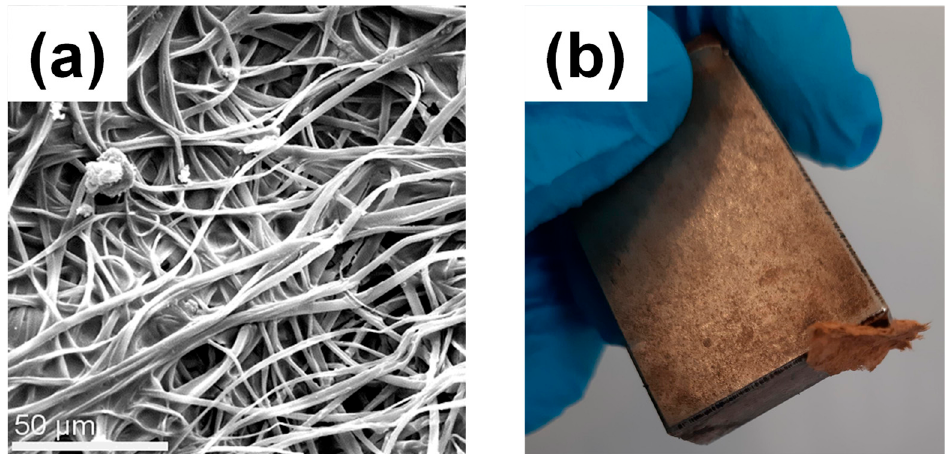
Figure 8. ( a ) Representative SEM image of the magnetically modified CA fibers decorated with MIONP-OAOA NPs. ( b ) Photograph of the magnetically modified membrane attracted by a magnet.